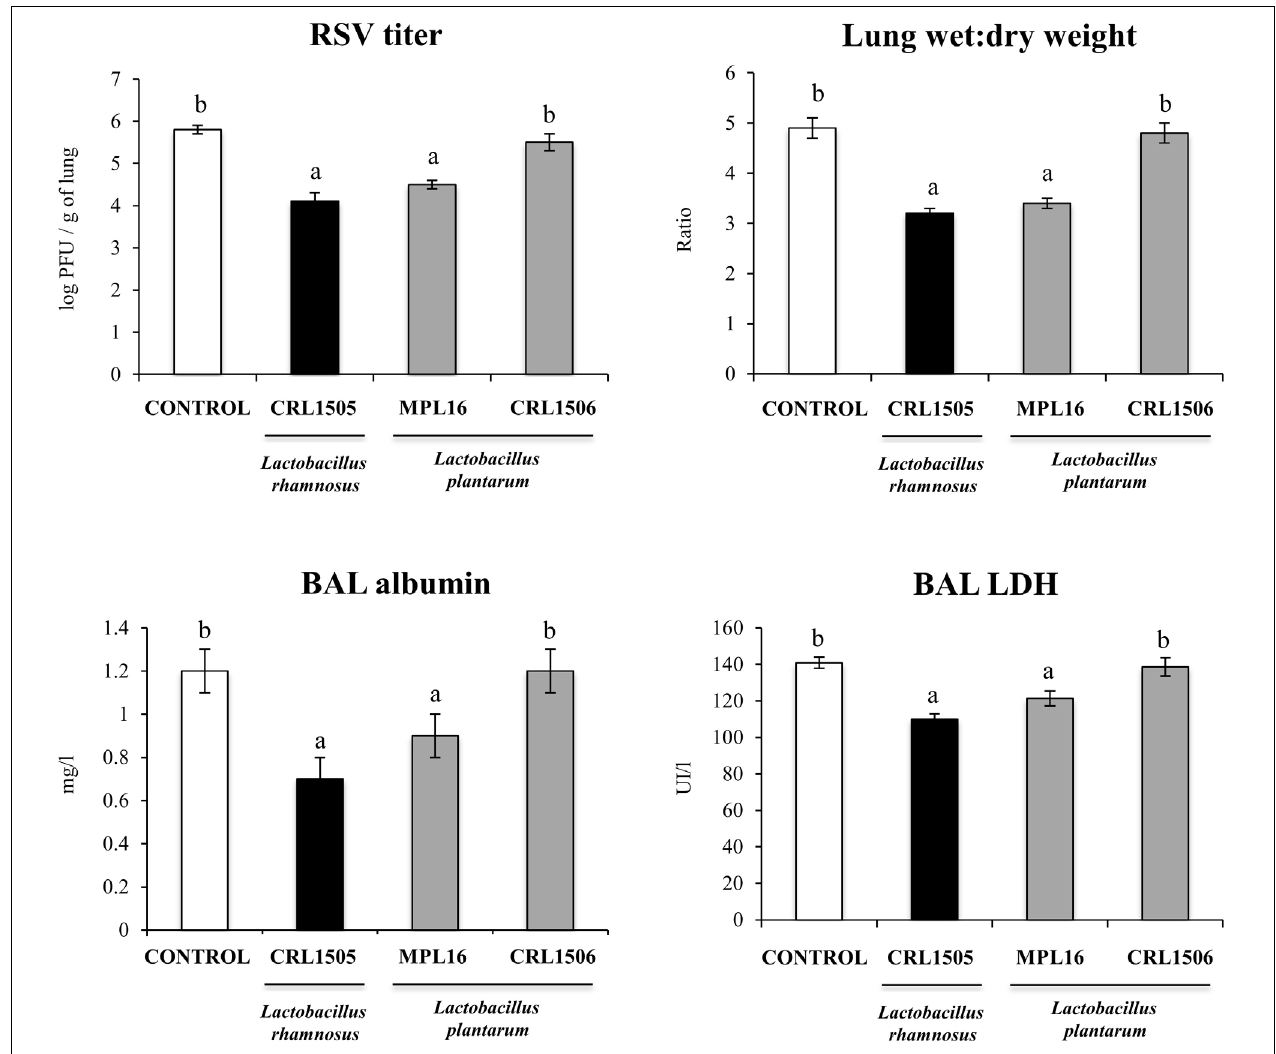
FIGURE 10 | Lung respiratory syncytial virus (RSV) titers, lung wet-to-dry ratio, and levels of bronchoalveolar lavage (BAL) injury markers [albumin and lactate dehydrogenase (LDH)] in mice orally treated with Lactobacillus rhamnosus CRL1505, Lactobacillus plantarum CRL1506, or L. plantarum MPL16 (10 8 cells/mouse per day for five consecutive days) and then challenged by the nasal route with RSV. Mice with no lactobacilli treatment and infected with RSV were used as controls. Respiratory syncytial virus titers and injury markers were evaluated on day 2 after viral infection. The results represent data from three independent experiments ( n = 6 per group). Letters indicate significant differences ( P < 0.05), a < b <